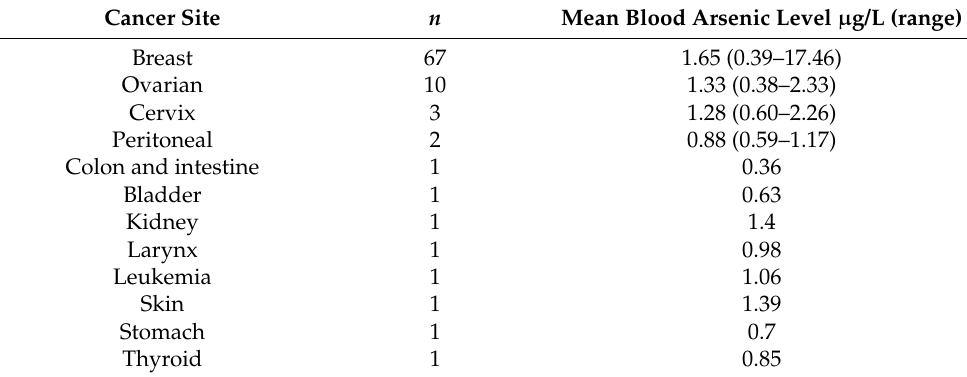
Table 2. Incident cancers detected in the cohort ( n = 90).